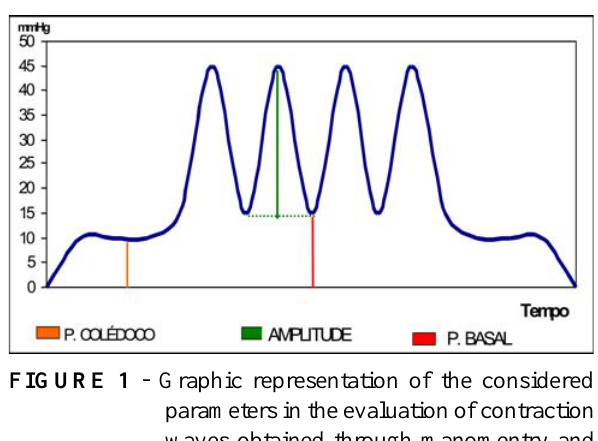
FIGURE 1 - Graphic representation of the considered parameters in the evaluation of contraction waves obtained through manomentry and registered in the